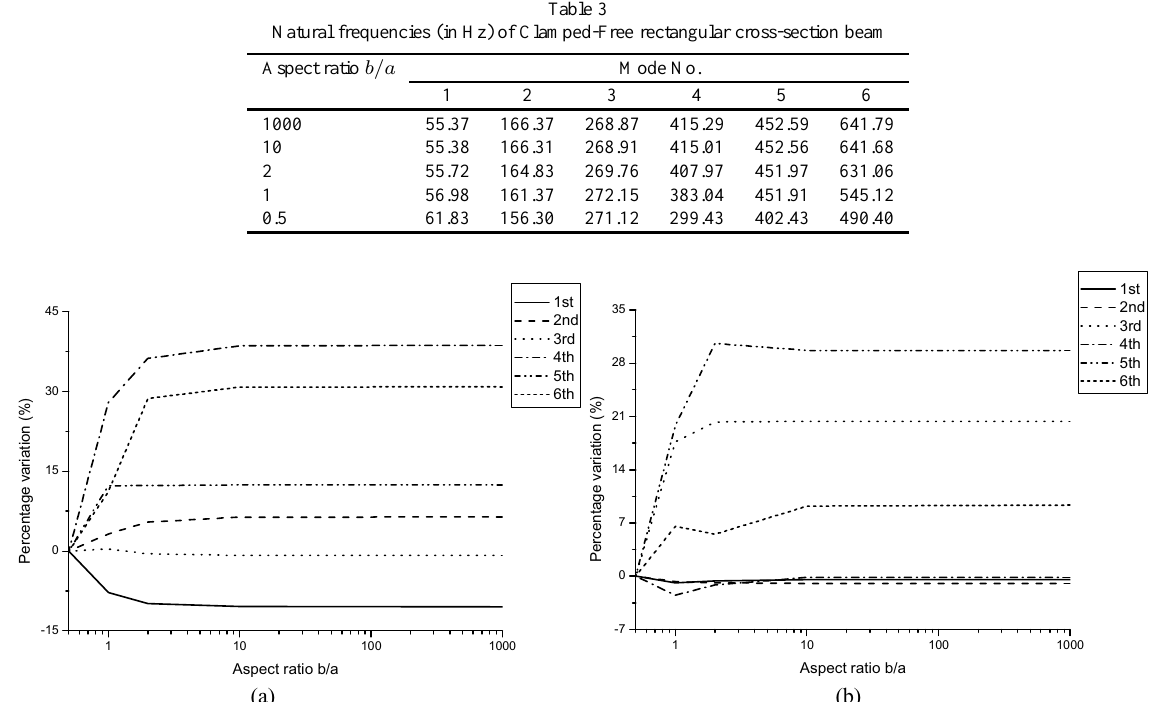
Fig. 5. Percentage variations of first six frequencies versus aspect ratio for (a) Clamped-Free and (b) Simply-Supported rectangular section